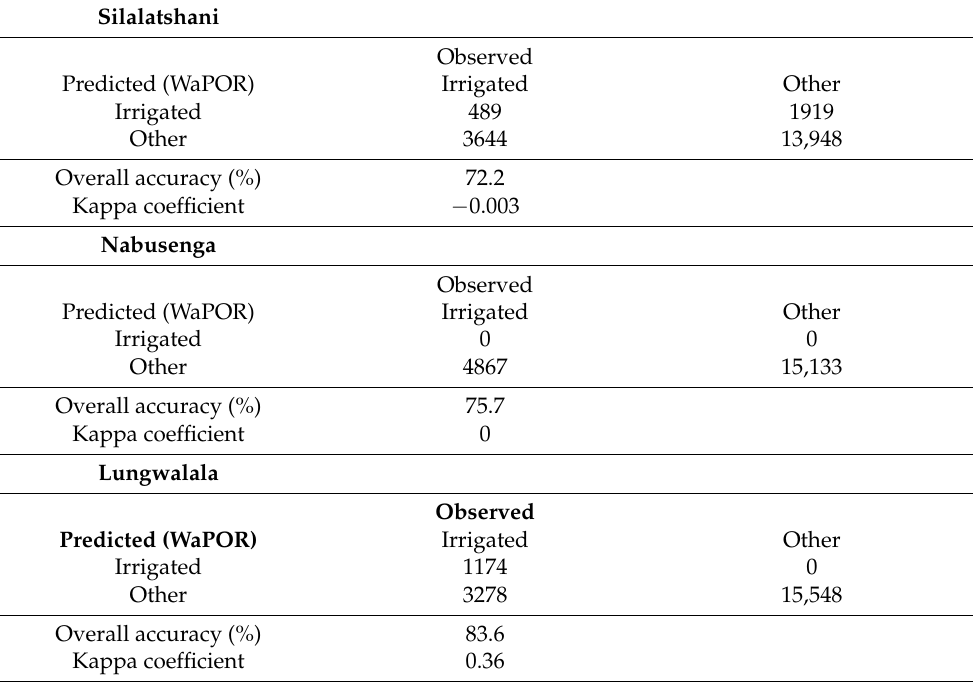
Table 5. Confusion matrices, overall accuracy, and Kappa coefficients for the Water Productivity through Open access of Remotely sensed derived data (WaPOR) classification product [40] perfor- mance on combined training and validation data (20,000